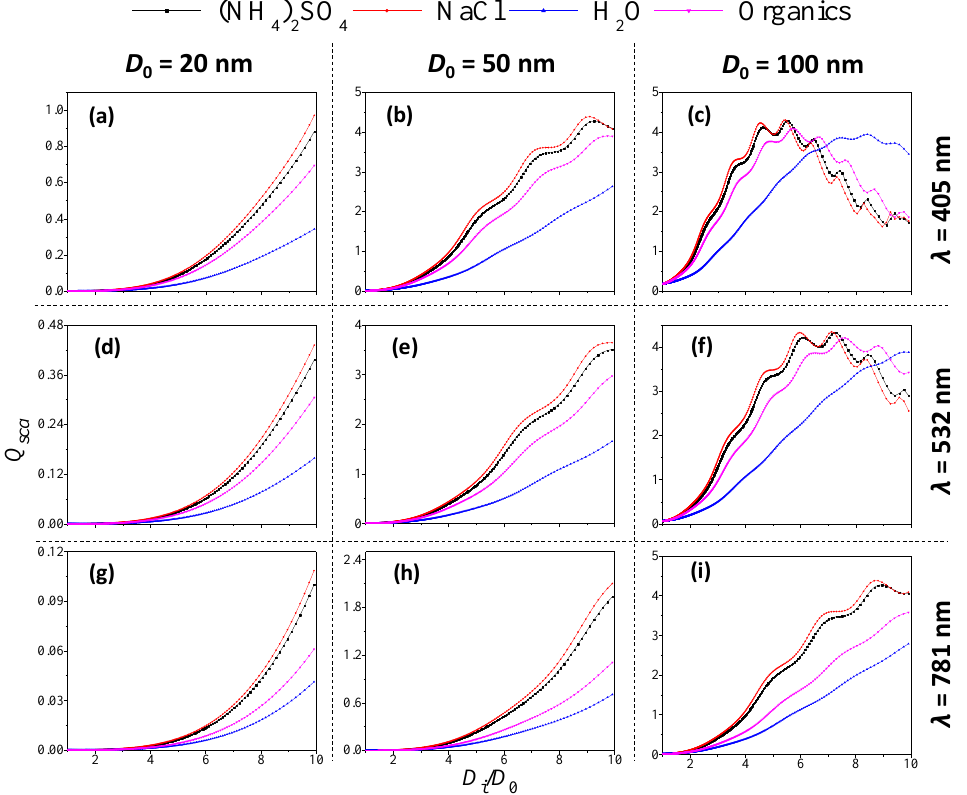
Figure 4. Variation in scattering efficiency ( Q sca ) with coating thickness ( D i /D 0 ) under various soot-particle coated materials ( λ = 405, 532 and 781 nm; soot particle core diameter D 0 = 20, 50 and 100 nm). ( a – c ): ( λ = 405 nm; soot particle core diameter D 0 = 20, 50 and 100 nm); ( d – f ): ( λ = 532 nm; soot particle core diameter D 0 = 20, 50 and 100 nm); ( g – i ): ( λ = 781 nm; soot particle core diameter D 0 = 20, 50 and 100 nm);